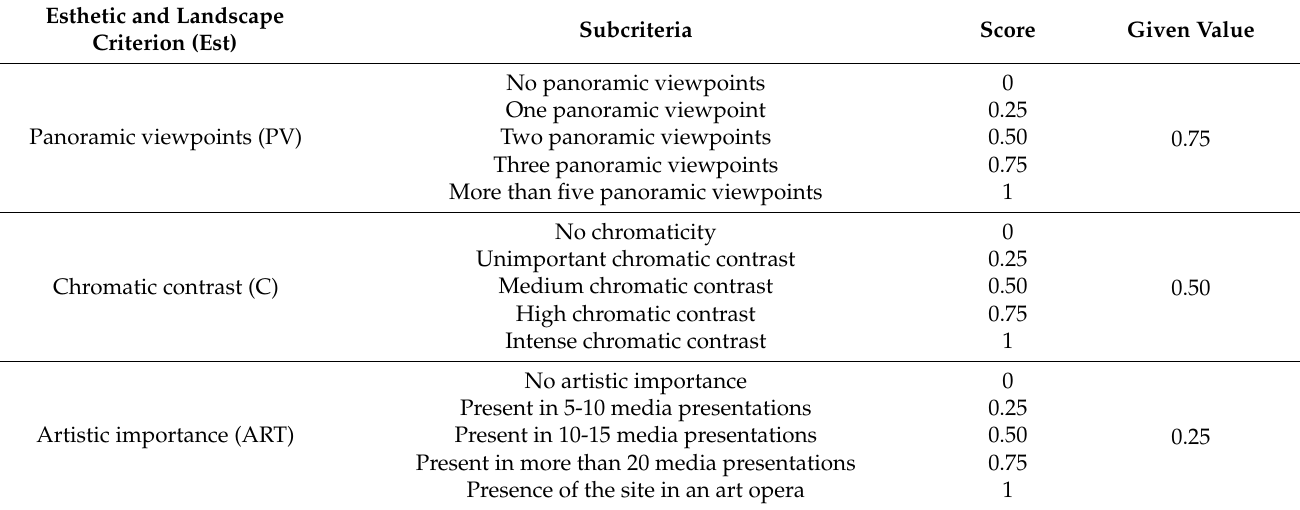
Table 4. Geomorphological value—the esthetic and landscape criterion